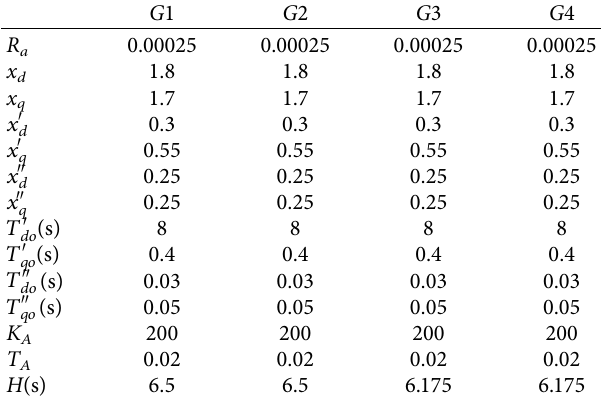
Table 2: Te understudy power system specifcations.